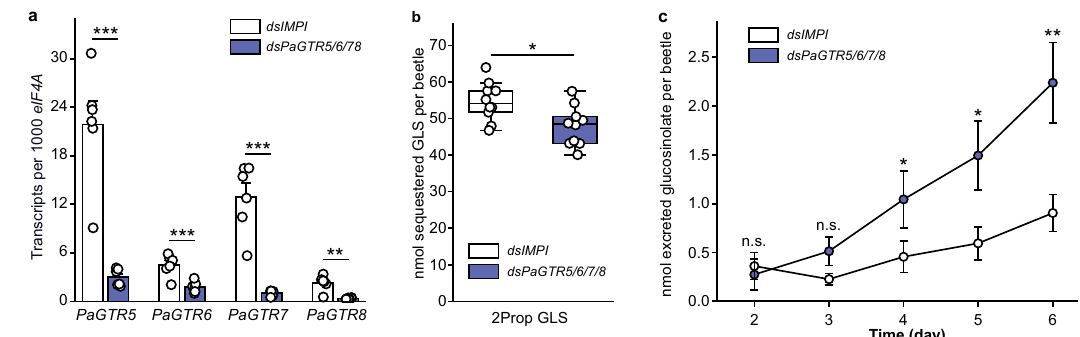
Fig. 4 In vivo functional characterization of glucosinolate transport mediated by PaGTR5/6/7/8 . a PaGTR5/6/7/8 expression in P. armoraciae 6 days after dsRNA injection ( n = 6 biological replicates, two beetles per replicate). b Accumulation of 2-propenyl glucosinolate (2Prop GLS) in adult P. armoraciae beetles after 6 days feeding on Arabidopsis leaves, followed by 1-day starvation. Box plots show the median, interquartile range, and outliers of each dataset ( n = 10 biological replicates, six beetles per replicate). c Excreted amounts of 2Prop GLS from day 2 until day 6 of feeding on Arabidopsis ( n = 10 biological replicates, feces of six beetles per replicate). Data are shown as mean ± s.e.m. Treatments were compared by two-tailed Student ’ s t test,